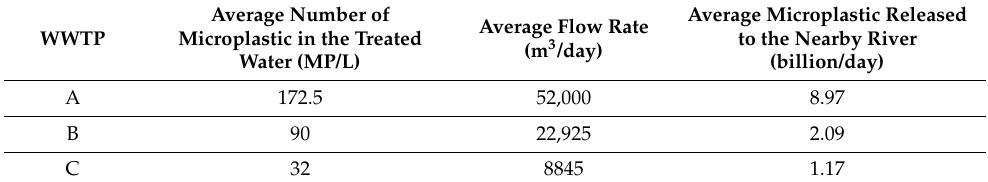
Table 2. Average microplastic loading